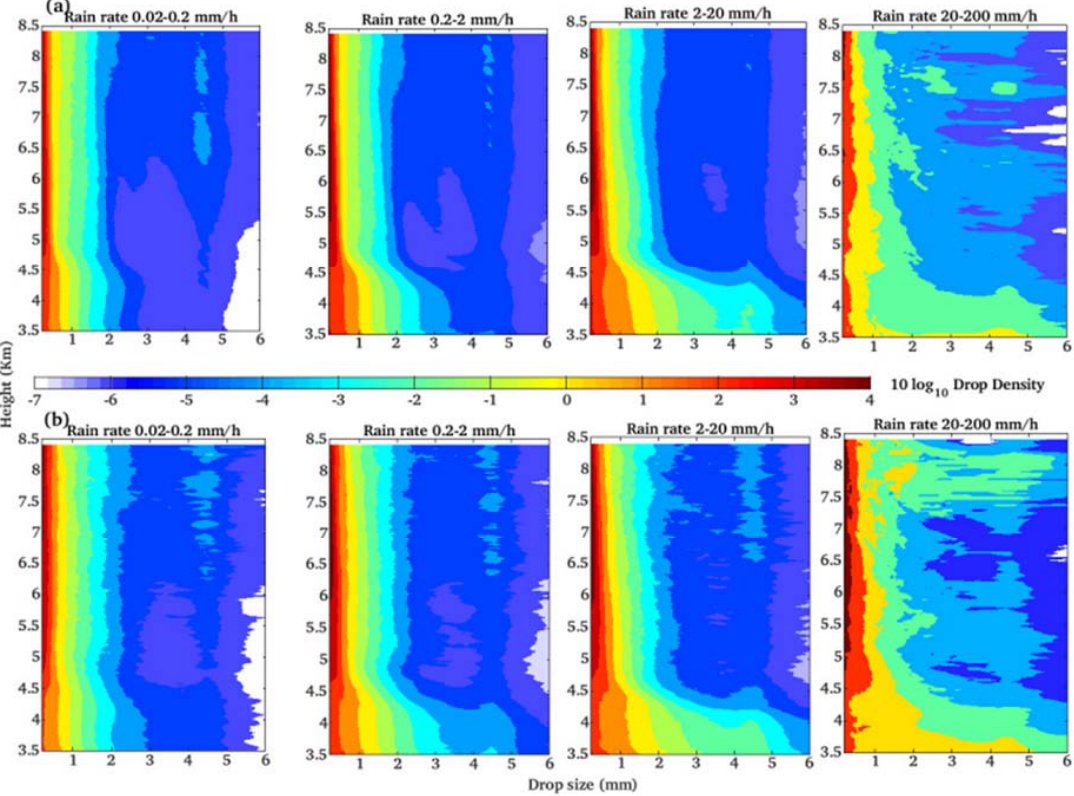
Figure 7. Vertical growth for raindrop size distribution (DSD) parameters for different near surface rain rate for ( a ) December to March months and ( b ) September to November months. The near surface rain rate is mentioned at the top of each panels.